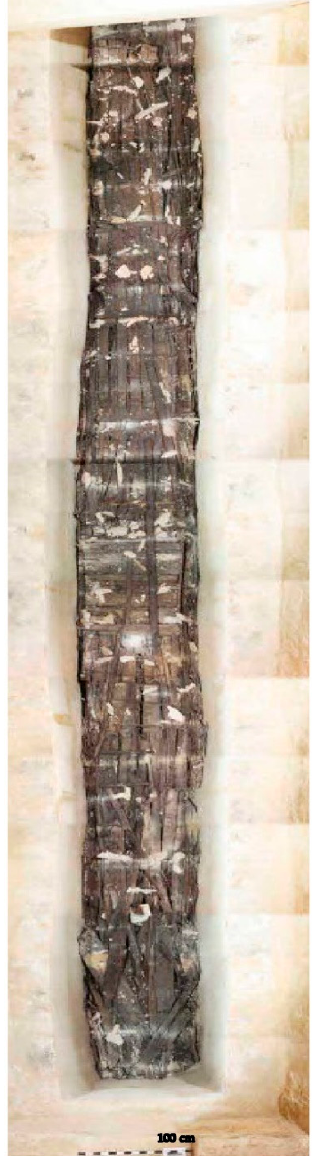
Figure 2. The second boat of King Khufu inside its pit.